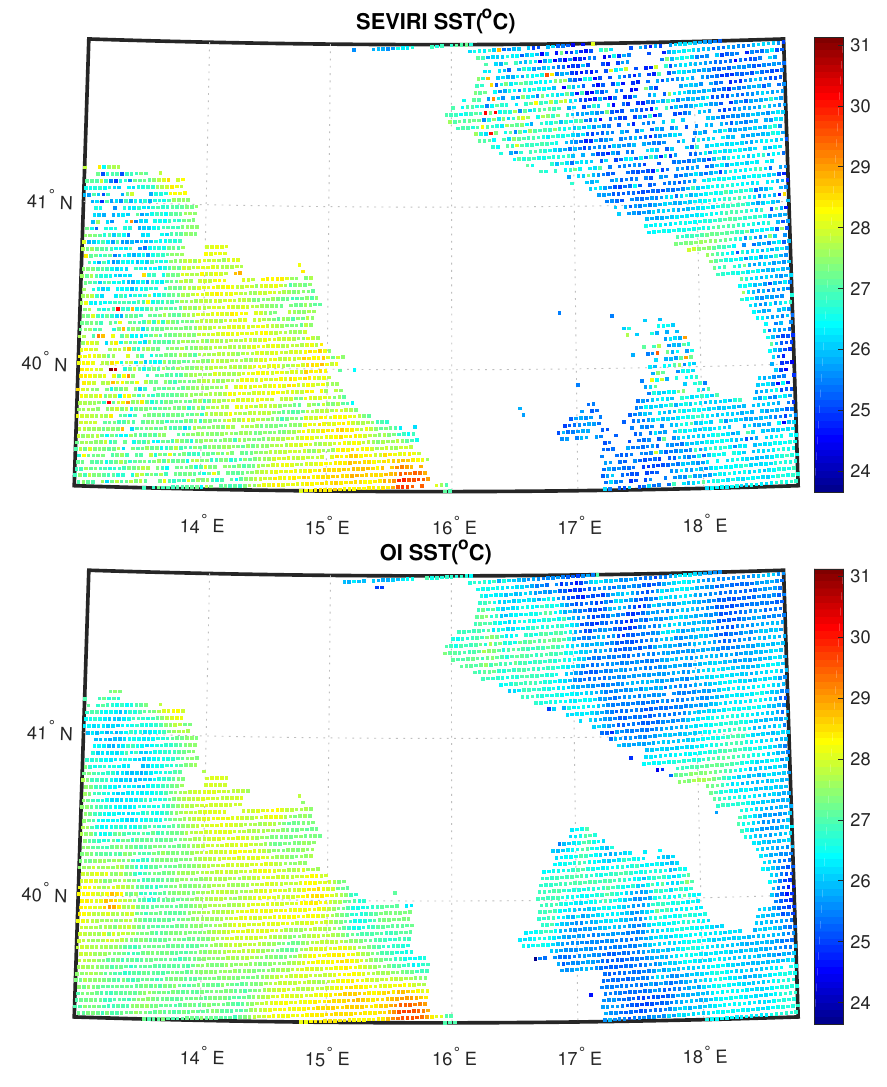
Figure 7. As Figure 5, but for 18:00